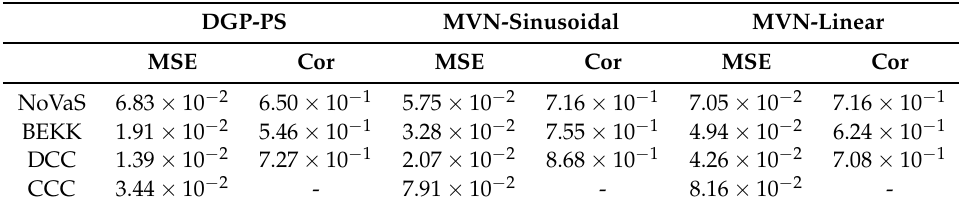
Table 3. MSE and correlation between realized correlation and estimated correlation by the respective method averaged over 1000 simulations. NoVaS corresponds to the best method according to Tables 1 and 2. For the BEKK, we fit a BEKK-GARCH(1,1,1) defined as in Engle and Kroner (1995).